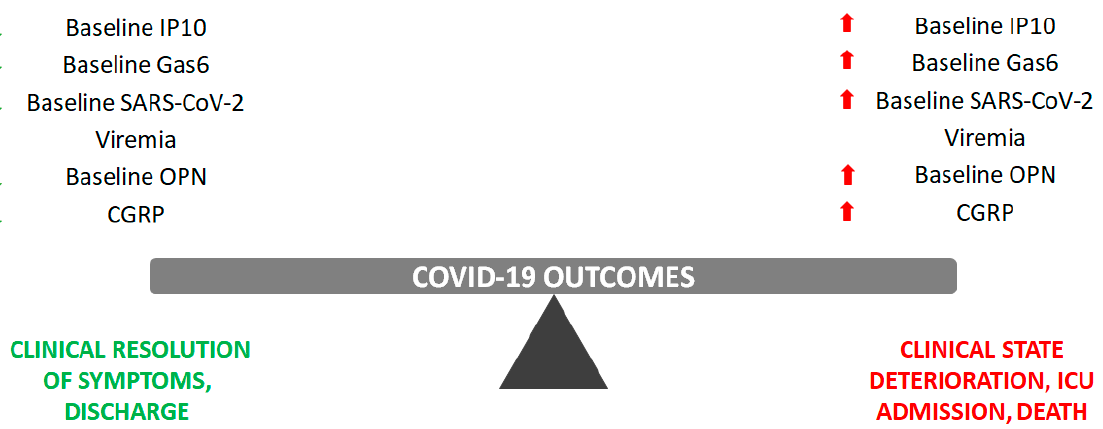
Figure 2. Summary of the most promising biomarker (IP10, Gas6, RNAemia, osteopontin, and CGRP) trajectories in predicting COVID-19 disease evolution.